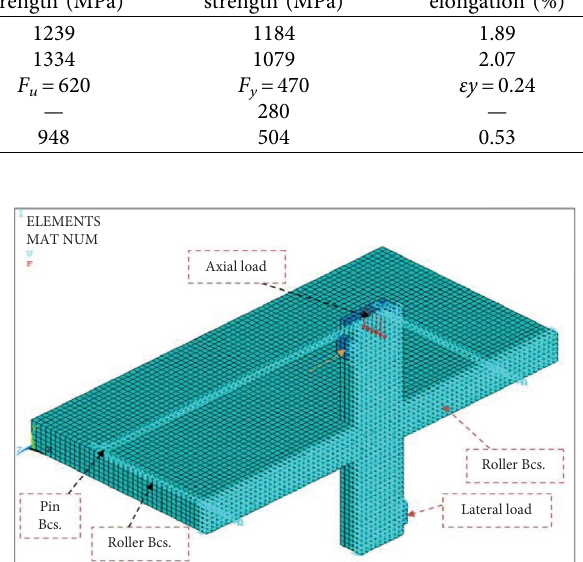
Figure 3: Geometry, meshing, loading, and boundary conditions of part-I